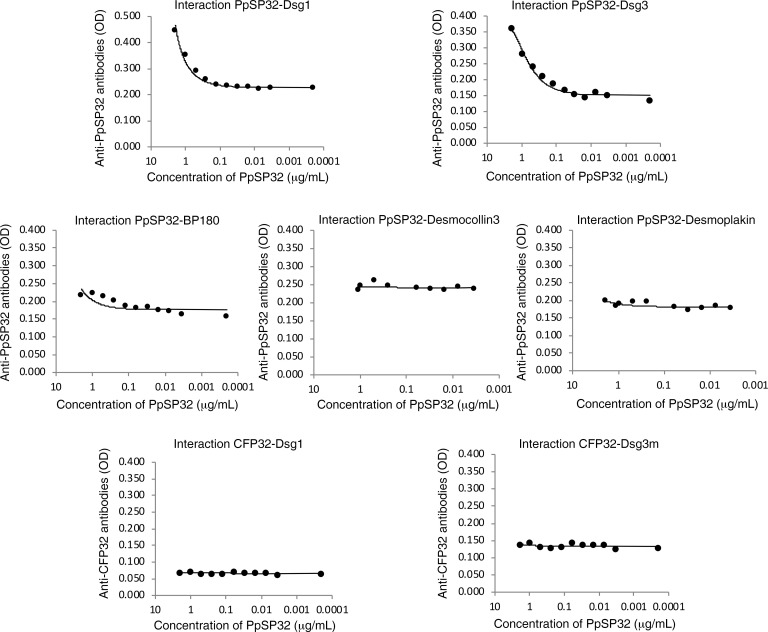
ELISA showing a specific and dose-dependent interaction between PpSP32 and the proteins Dsg1 and Dsg3.The ELISA plates were coated with the recombinant proteins Dsg1 and Dsg3 or other epidermal proteins; BP180, desmocollin 3 and desmoplakin and then incubated with a decreasing concentration of rPpSP32, the protein of interest or CFP32, a control protein. The plates were then incubated in the presence of human sera with anti-PpSP32 or -CFP32 antibodies. The results are representative of 3 independent experiments. Significant differences were found between the different PpSP32 concentrations for Dsg1 and Dsg3 (P = 0.006 and P = 0.008 between the condition 2 μg/mL and 0.0002 μg/mL for Dsg1 and Dsg3, respectively). For the control proteins, no significant difference was obtained while decreasing the concentration of PpSP32 (P > 0.05).